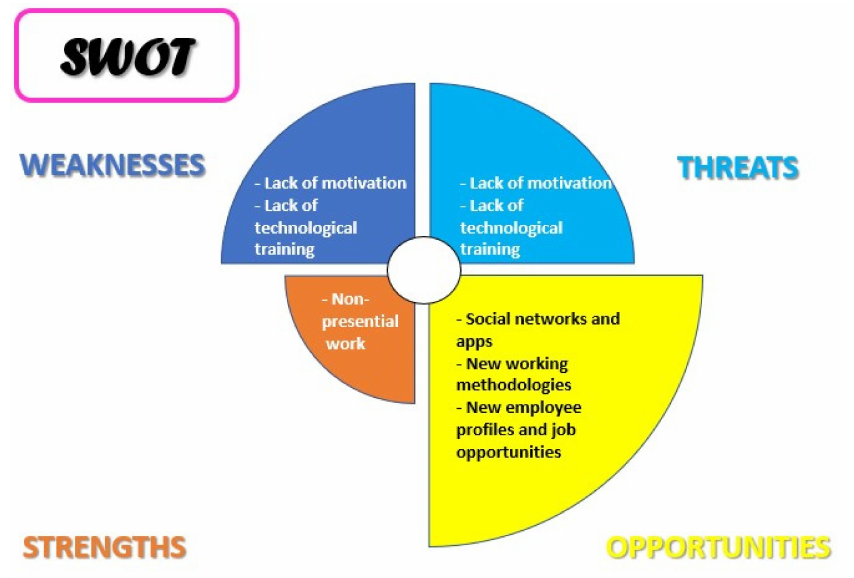
Figure 9. SWOT working group. Source: own elaboration.